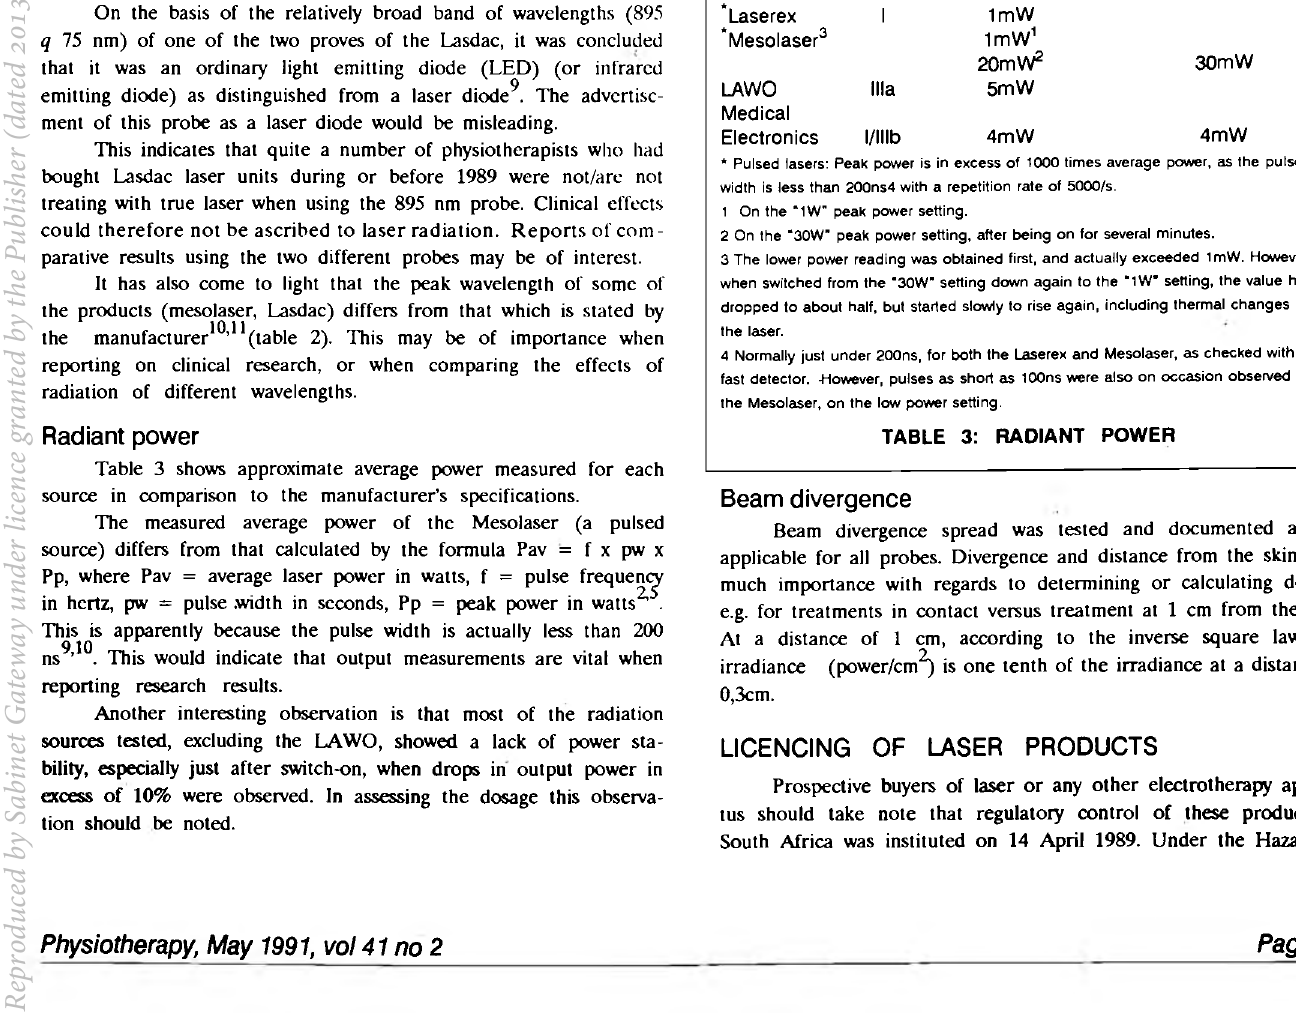
TABLE 1: DETAILS OF EQUIPMENT INVESTIGATED Spectral properties